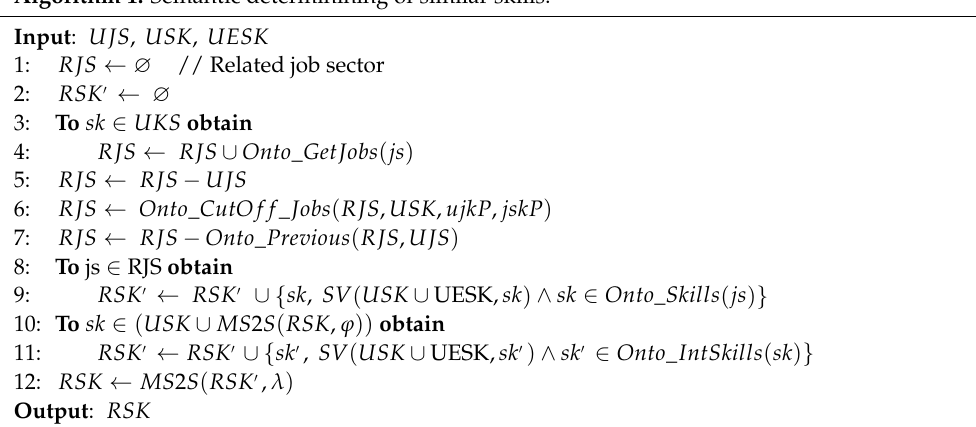
Algorithm 1: Semantic determinining of similar skills.